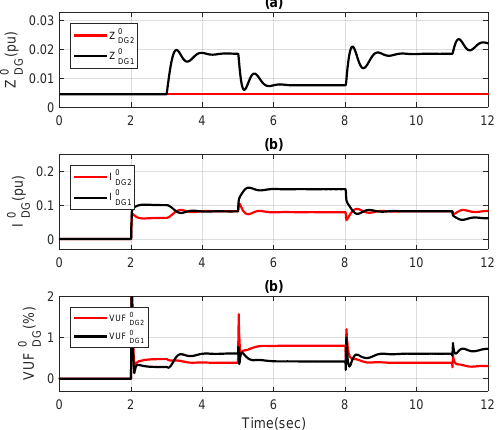
Figure 17. Zero-sequence ( a ) output impedance, ( b ) current, and ( c ) VUF of DG units.